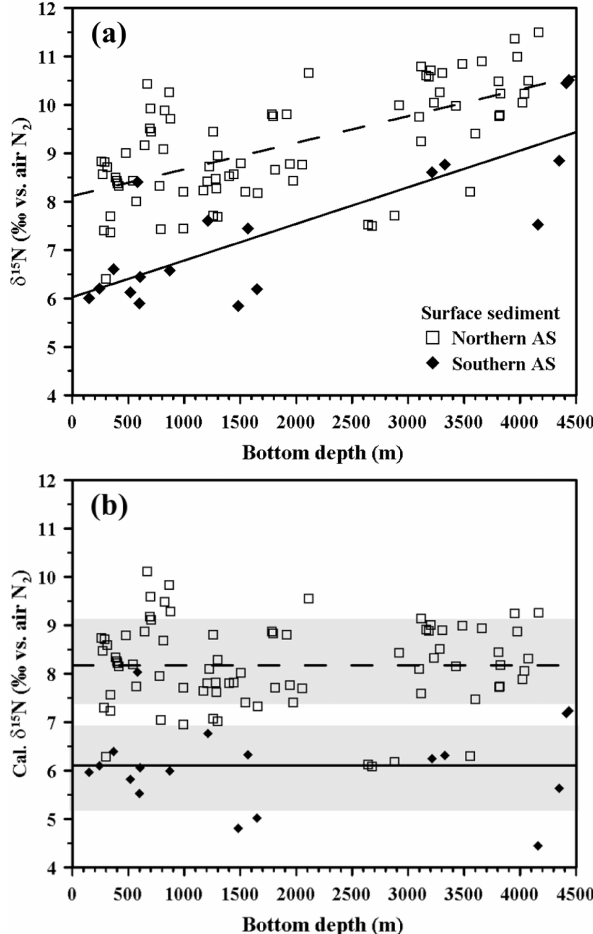
Figure 7. (a) Non-corrected δ 15 N values of modern surface sed- iments against corresponding bottom depth in the northern and southern Arabian Sea (see text for N–S boundary). Regression lines were shown in dashed and solid lines, respectively, for the northern and southern AS. (b) Corrected surface sedimentary δ 15 N values against water